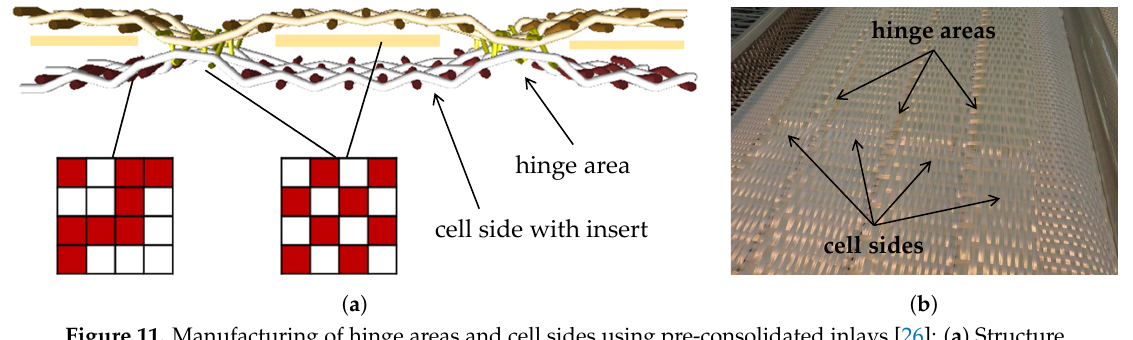
Figure 11. Manufacturing of hinge areas and cell sides using pre-consolidated inlays [26]: ( a ) Structure and weave pattern design. ( b ) Weave trials.